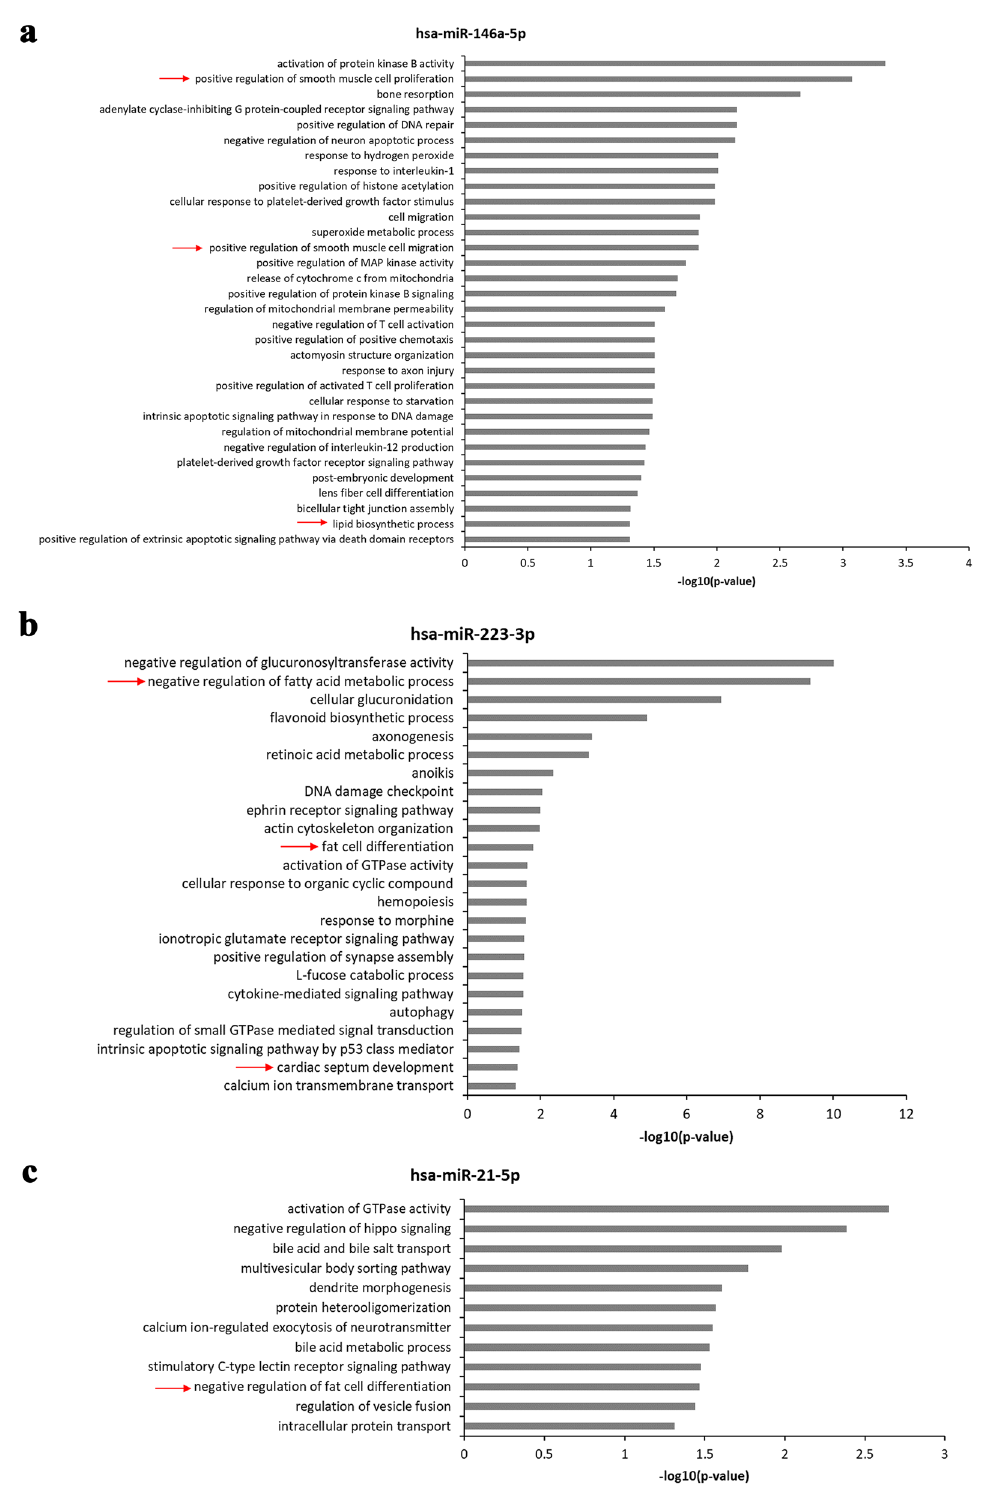
Figure 5. DAVID functional analysis for genes identified by miRWalk algorithm to be potentially targeted by the selected miRNAs i.e. miR-146a-5p ( a ), miR-223-3p ( b ) and miR-21-5p ( c ). The red arrows ( → ) show the metabolic processes known to be altered in dyslipidemia and